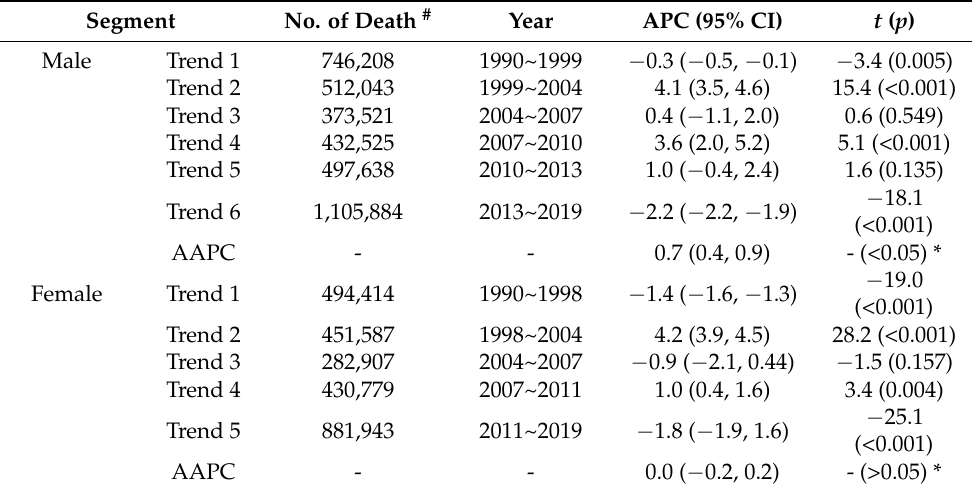
Table 2. Annual percent change for age-standardized mortality attributable to low whole-grain intake by gender in China, 1990–2019.